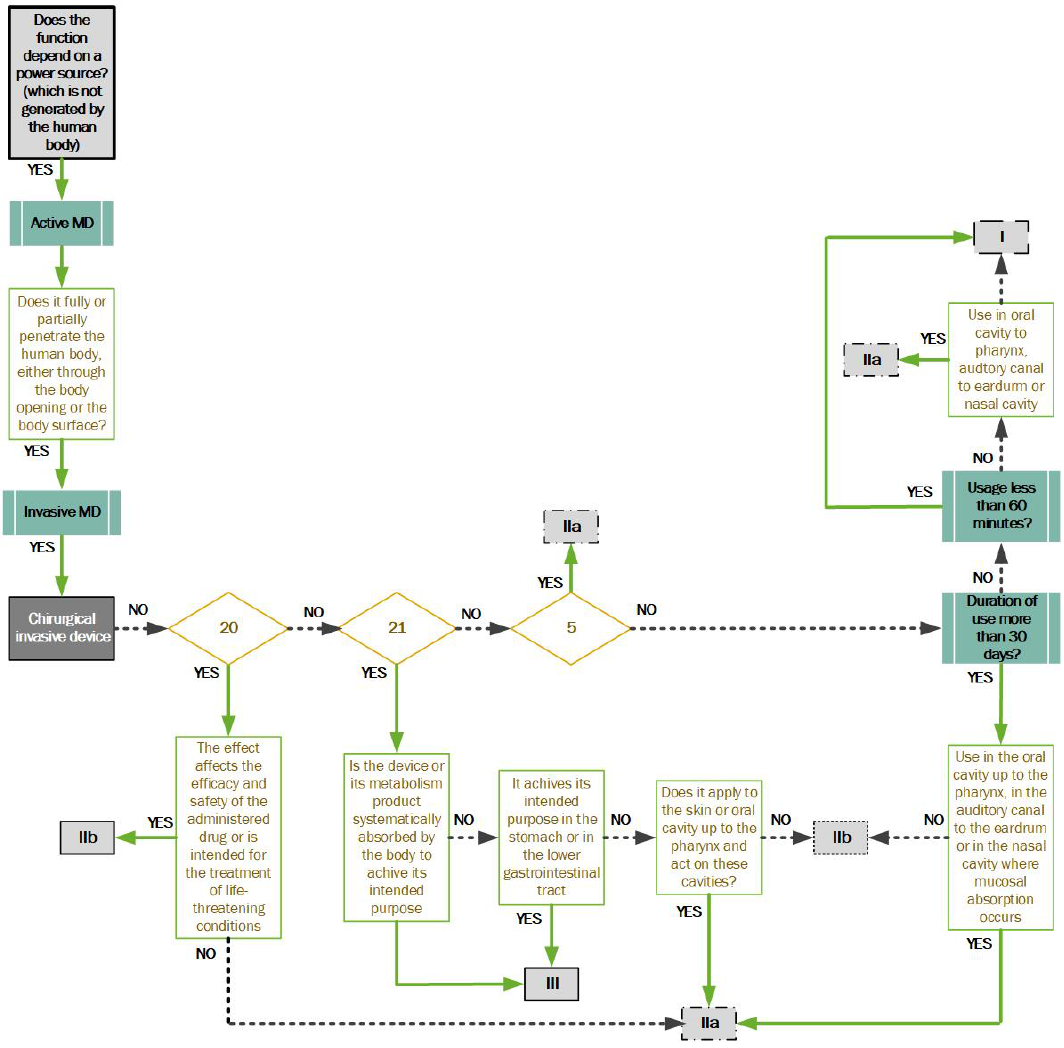
Figure 4. The fourth phase of the decision. Figure 5: If the fourth phase does not meet the classification, the manufacturer continues to the fifth phase. Rule 6—surgically invasive devices for transient use; Rule 7—surgically invasive devices for short term use; Rule 8—surgically invasive devices for long term use and implantable (including any device administering medicinal products, surgical mesh, or spinal